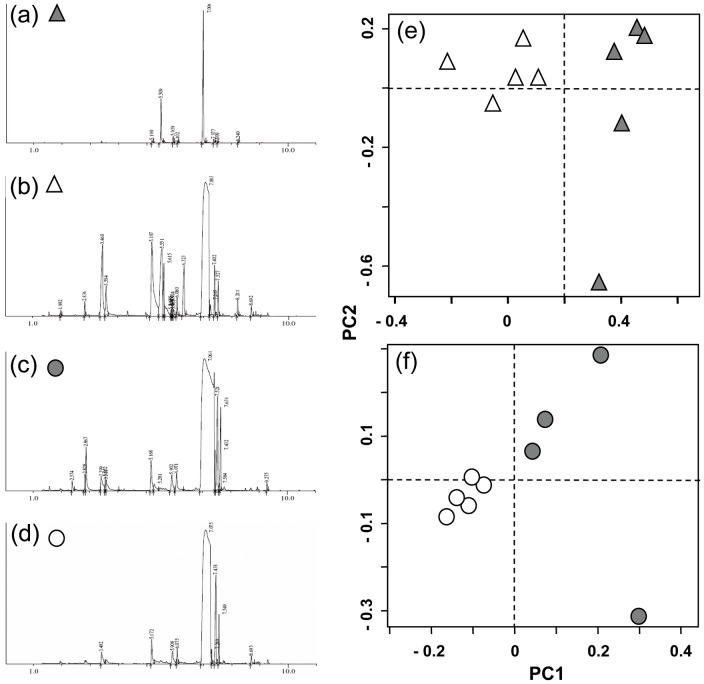
Chromatograms and principal component analysis of the chemical components in test-food items.Representative chromatograms are shown for (A) red, young leaves (Photinia: shaded triangle), (B) green, mature leaves (open triangle), (C) red, ripe tomatoes (Solanum lycopersicum: shaded circle), and (D) green, unripe tomatoes (open circle), obtained by solid phase microextraction, followed by gas chromatography and mass spectrometry. Also shown are the results from the respective principal component analyses (PCA) of the chemical components identified in both red and green (E) leaves and (F) fruit. Dashed lines represent the two main PC axes.